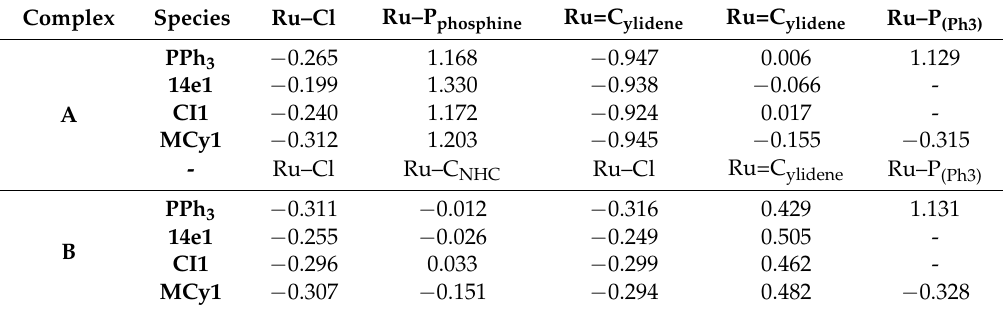
Table 4. Natural bond order (NBO) charges for complexes A and B (in